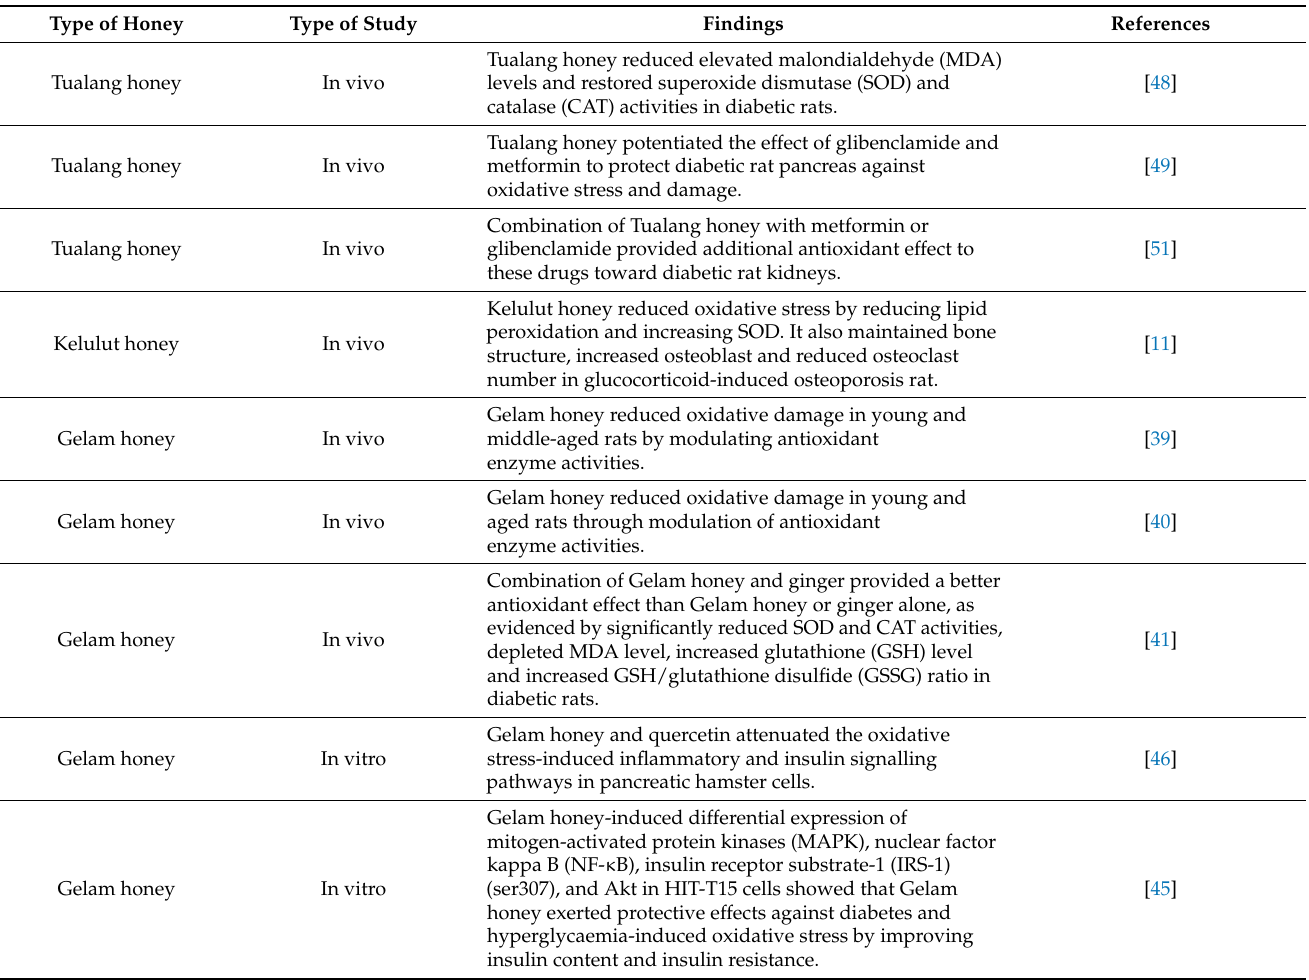
Table 3. Summary of anti-oxidative